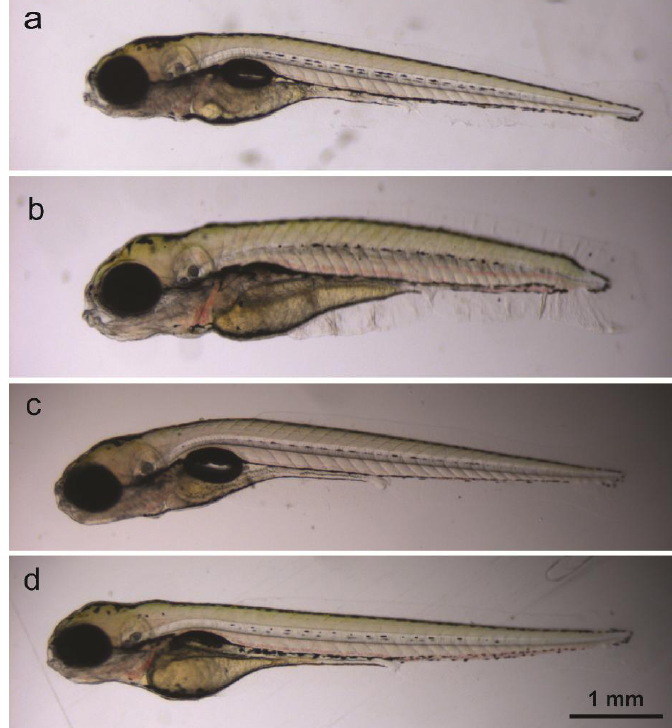
Figure 4. Lateral view of untreated five-dpf eleuthero-embryo ( a ), and of compound-treated eleuthero-embryo with abnormal body shape and non-inflated swim bladder ( b ), with curved body ( c ) and with non-inflated swim bladder ( d ).